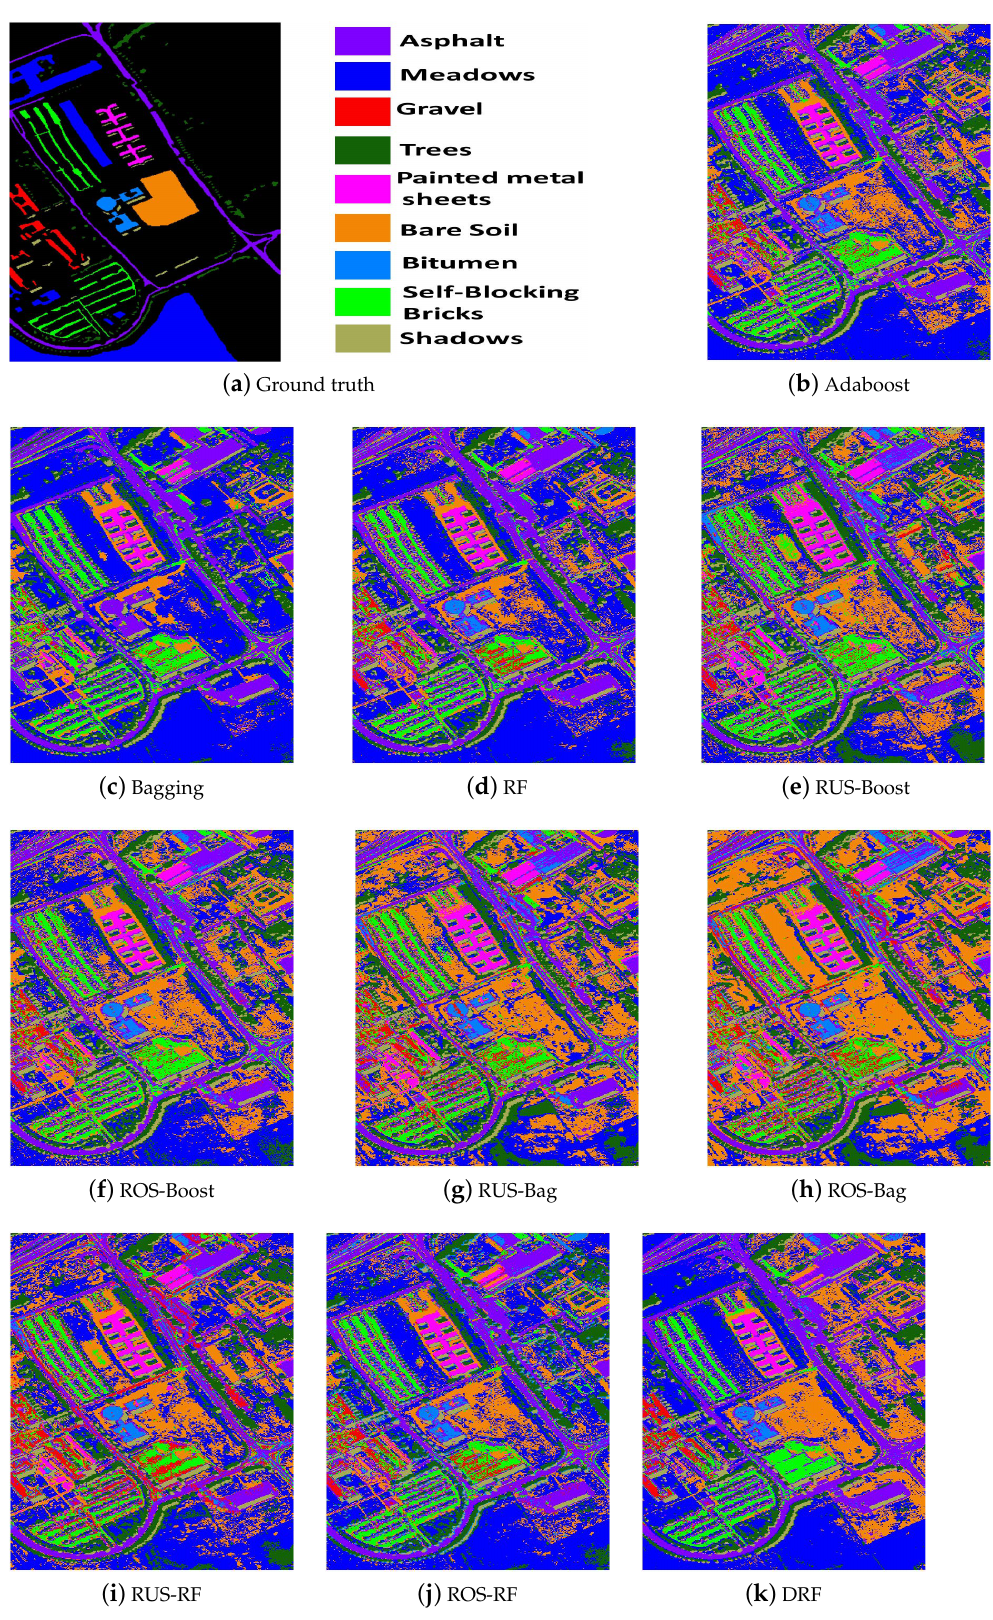
Figure 4. Ground truth, classification maps of Adaboost, Bagging, random forest, random undersam- pling combined, random oversampling combined Adaboost, Bagging, and random forest, and the proposed double random forest DRF, on the hyperspectral data University